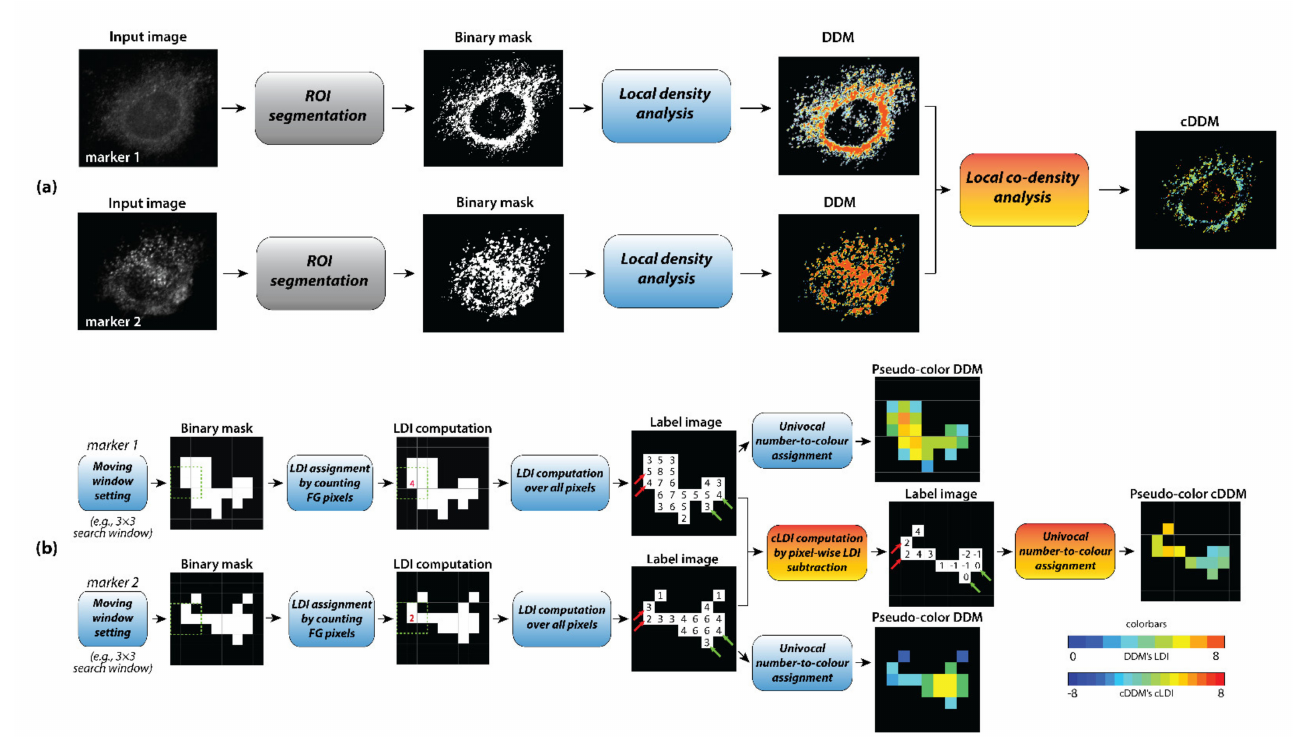
Figure 1. Flowchart of cDDM creation pipeline for a couple of markers. ( a ) The acquired images are segmented in binary masks and their pixel connectivity separately explored by local density analysis for the two pseudo-color DDMs building. Then, the cDDM is built through local co-density analysis, by comparing the single markers DDMs pixelwise. ( b ) Details of local density (blue boxes) and co-density (orange boxes) analyses: after setting the search (moving) windows size, each foreground (FG) pixel of each binary mask is assigned a number representing the amount of FG pixels in its locality, this constituting the input to build the pseudo-color DDM (here shown with no “saturated” densities). Then, the local co-density analysis is performed by pixelwise subtraction of the two